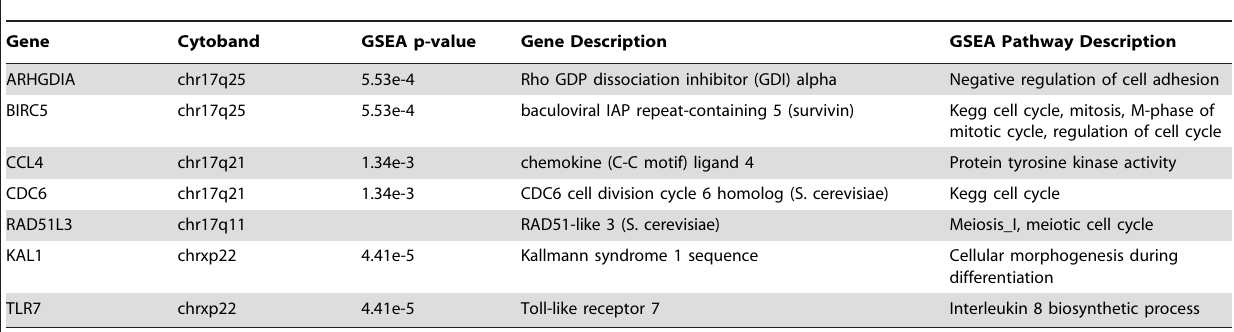
Table 4. Details for genes associated with Chromosomes 17 and